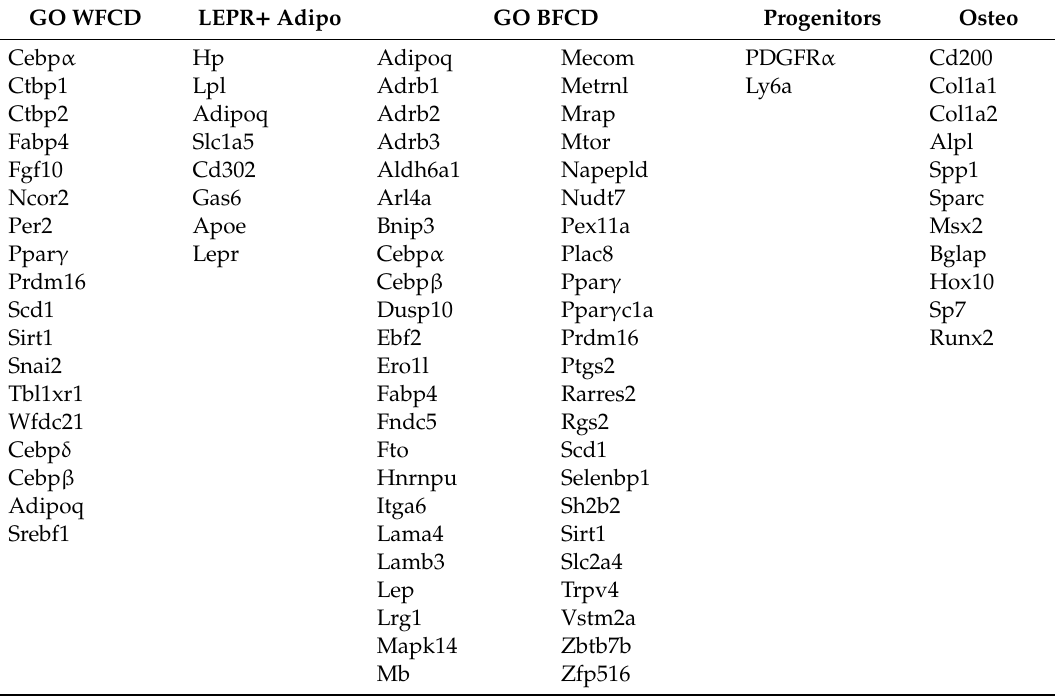
Figure 4. Single Cell RNA Sequencing reveals di ff erent BM cell composition between wt and hypomorphic samples. ( A ) t-SNE plot of single Cell RNA sequencing, performed on wt (upper panel) and Prep1 i/i (lower panel) fresh Bone Marrow Stromal Cells, shows eight distinct transcriptional clusters, through Loupe Cell Browser visualization. Clusters specific for each sample are highlighted by dotted squares. ( B ) The heatmap shows unique molecular signatures displayed by each cluster. Table 2. Gene signatures characterizing the indicated GO categories, or the LEPR + Adipo